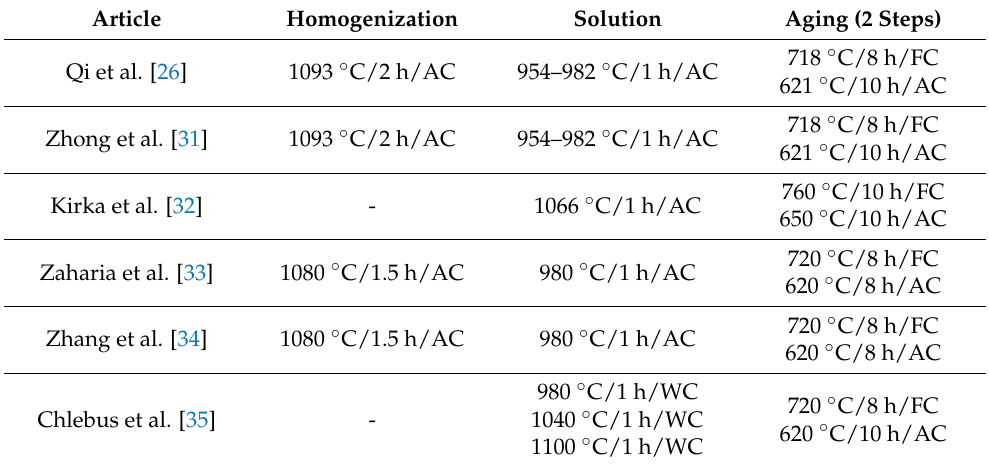
Table 3. Heat treatments applied for Inconel 718 in different articles: (AC) air cooling, (WC) water cooling, (FC) furnace